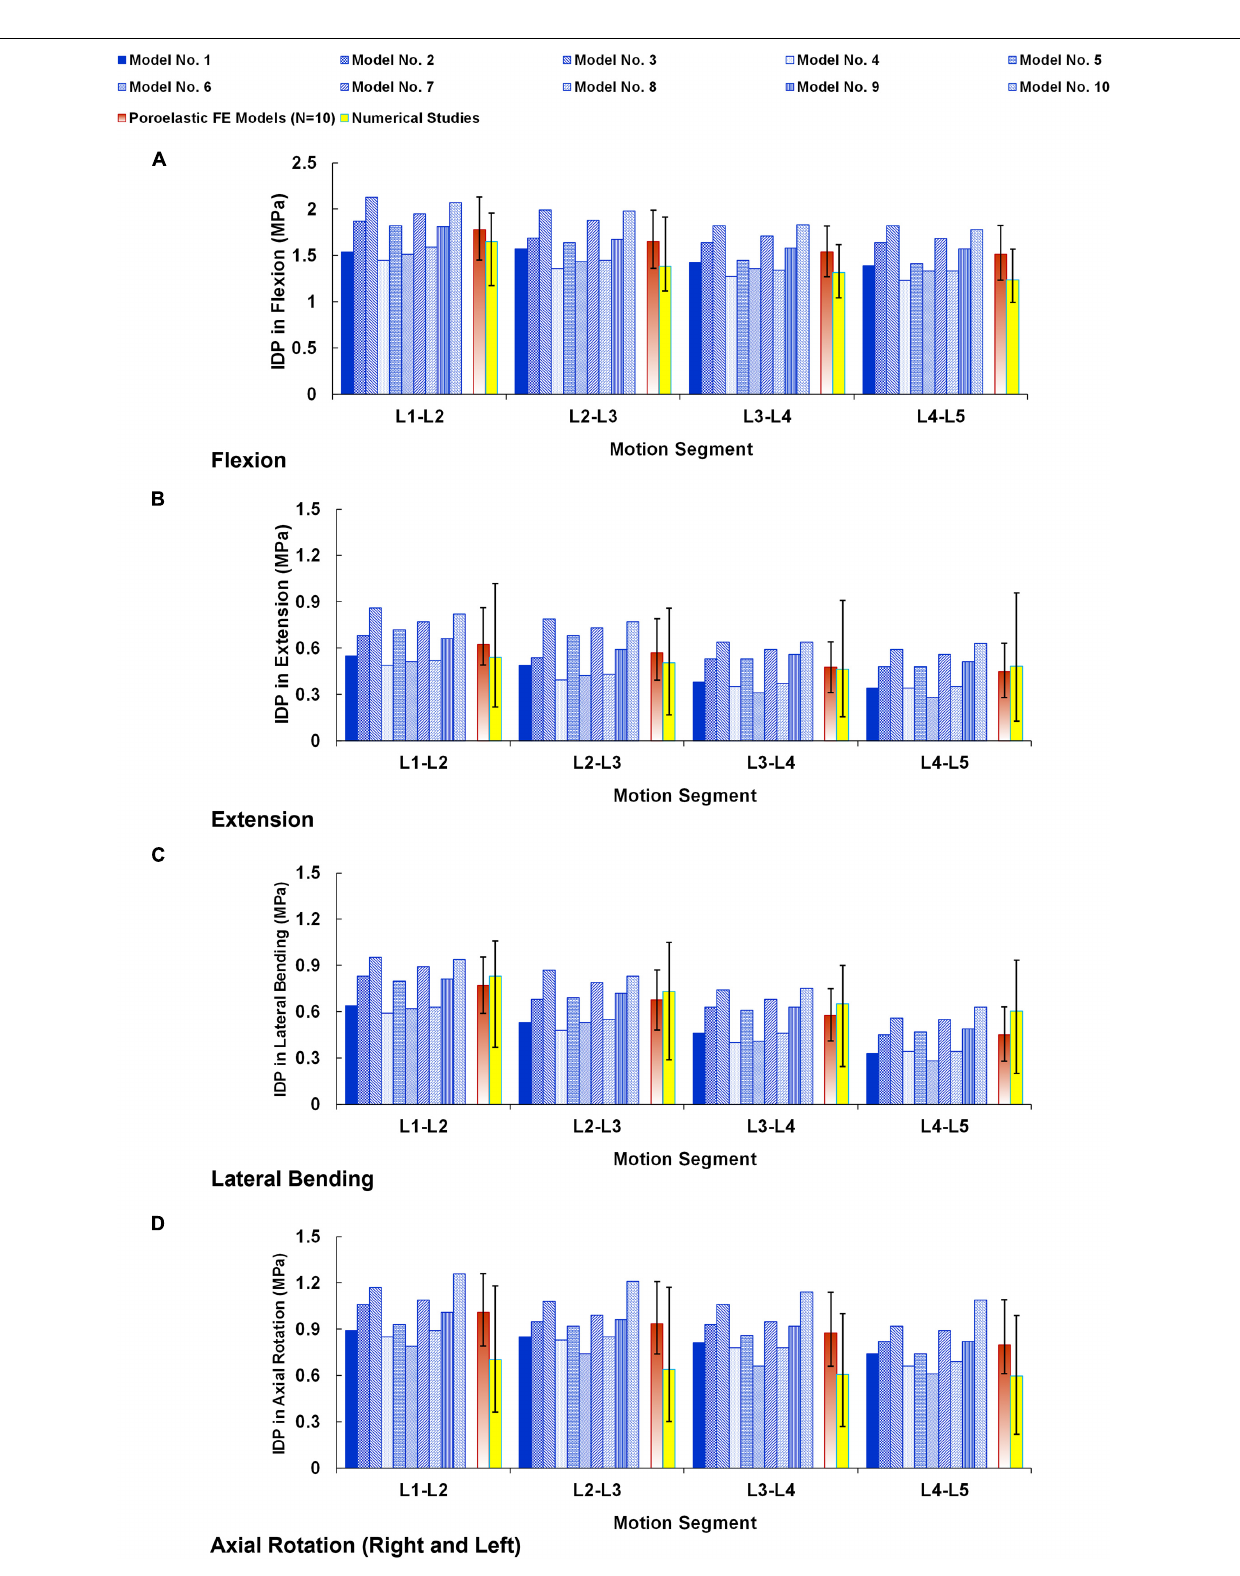
FIGURE 5 | Intradiscal pressure (IDP) for preoperative FE models compared with the numerical studies (Dreischarf et al., 2014) in (A) flexion, (B) extension, (C) lateral bending, and (D) axial rotation. The reported IDPs in lateral bending and axial rotation are the average in the left and right directions. The error bars indicate the ranges of the